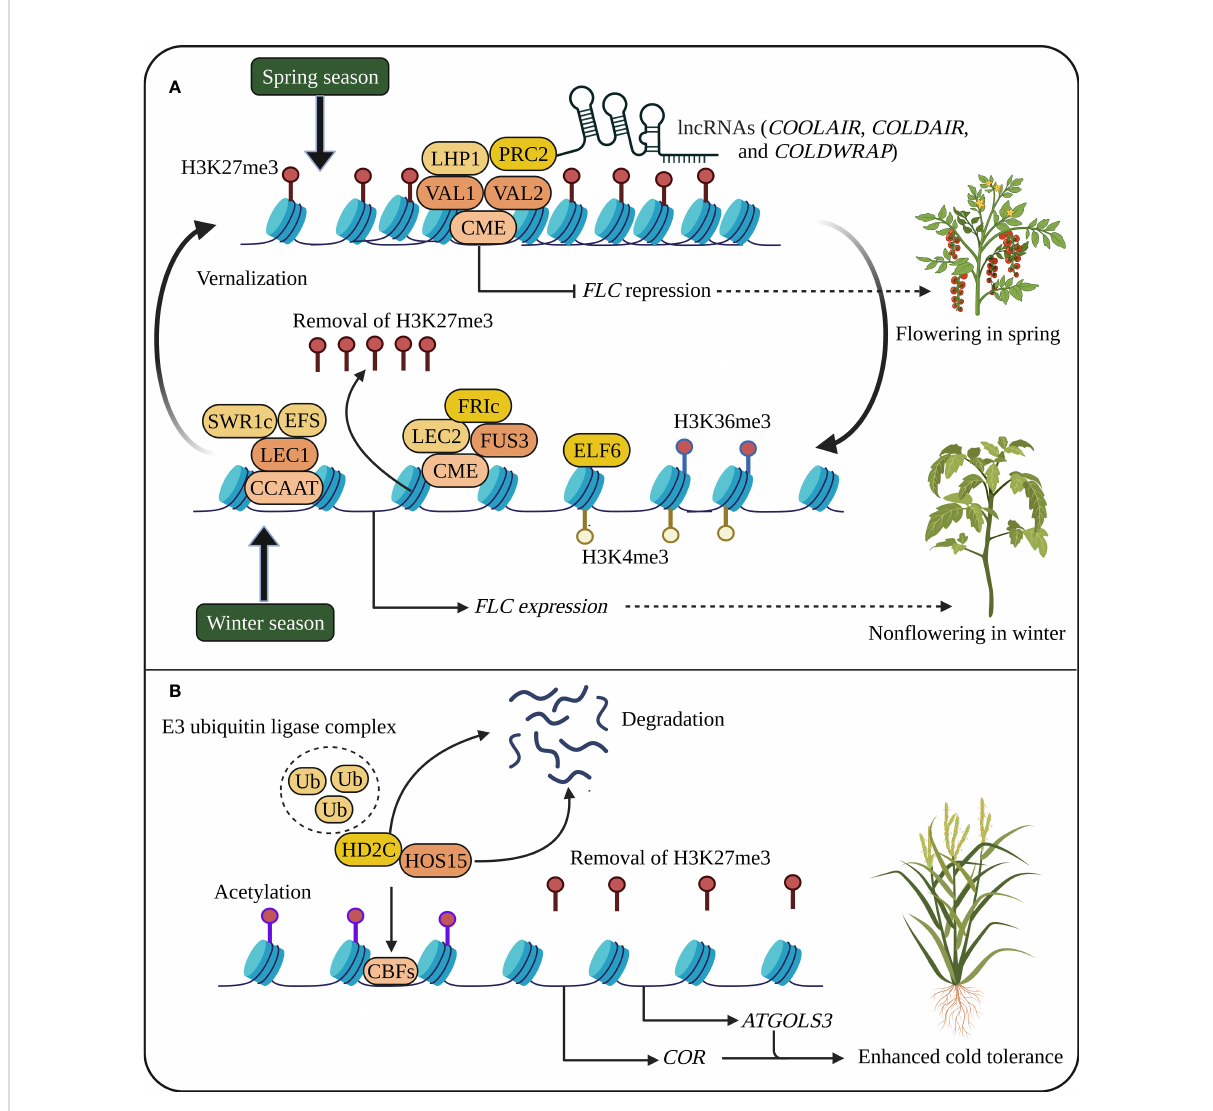
FIGURE 1 Cold stress memory in plants. (A) Flowering Locus C ( FLC ) expression suppresses fl owering at high levels during winter. During vernalization, cold memory cis -acting element (CME), B3 transcription factors (TFs) such as Viviparous1 ( VAL1 and VAL2 ), LIKE HETEROCHROMATIN PROTEIN 1 (LHP1), Polycomb repressive complex 2 (PRC2), and long noncoding RNAs (lncRNAs) silence FLC activation, and the spread of H3K27me3 throughout the FLC locus during cell division and DNA replication leads to FLC repression. In the next generation, epigenetic cold memory